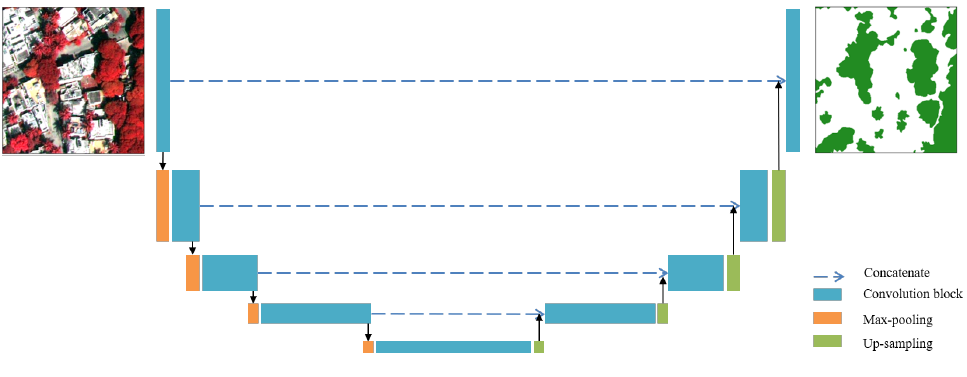
Figure 3. The architecture of